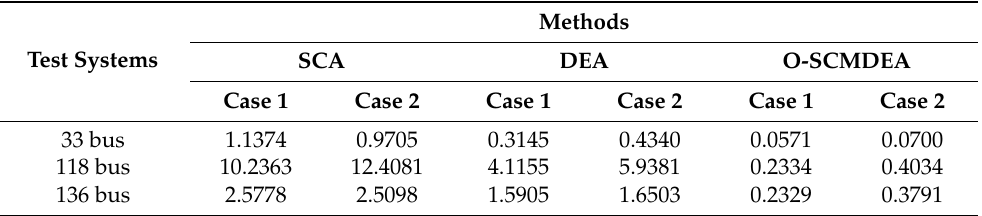
Table 17. Friedman–ANOVA test of O-SCMDEA for scenario I applied to the different test systems.